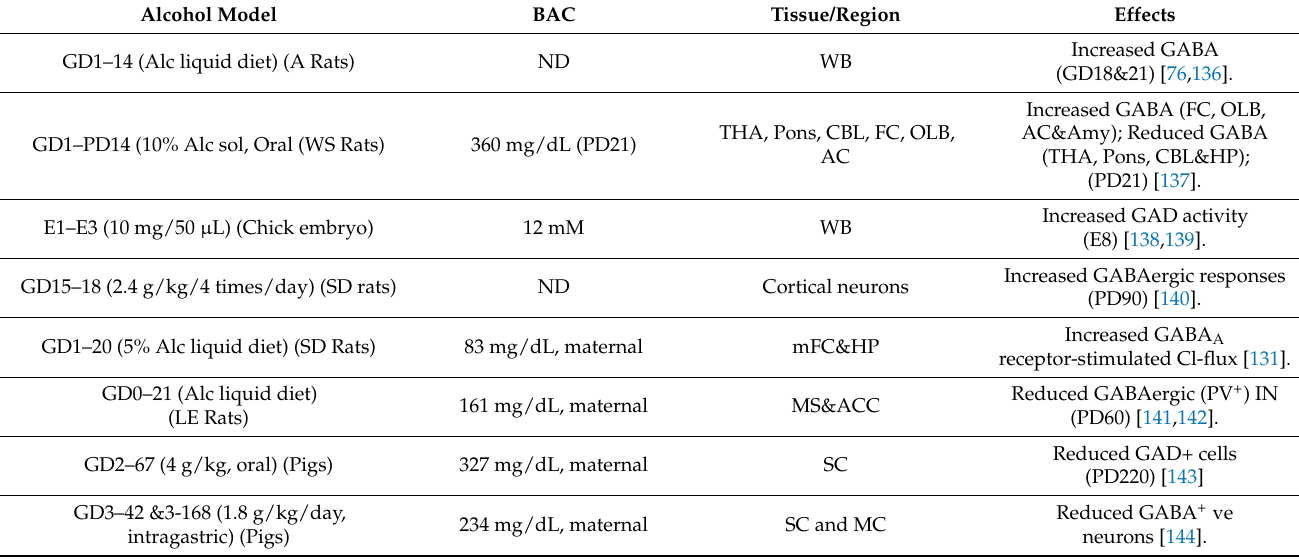
Table 2. Summary of developmental alcohol exposure effects on GABAergic neurotransmitter